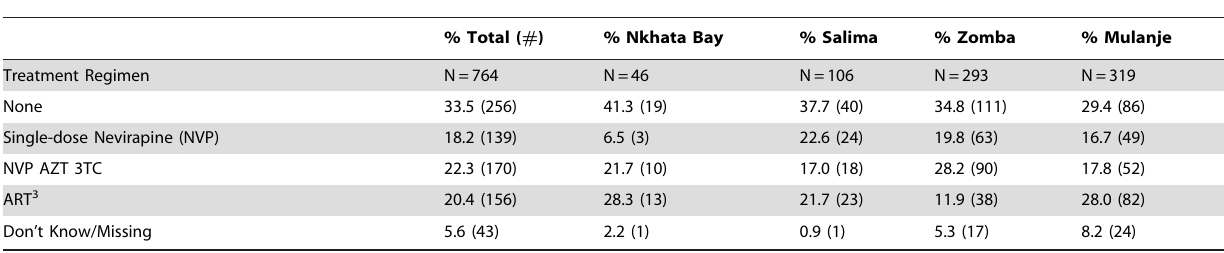
Table 3. HIV Treatment Regimen During Labor.